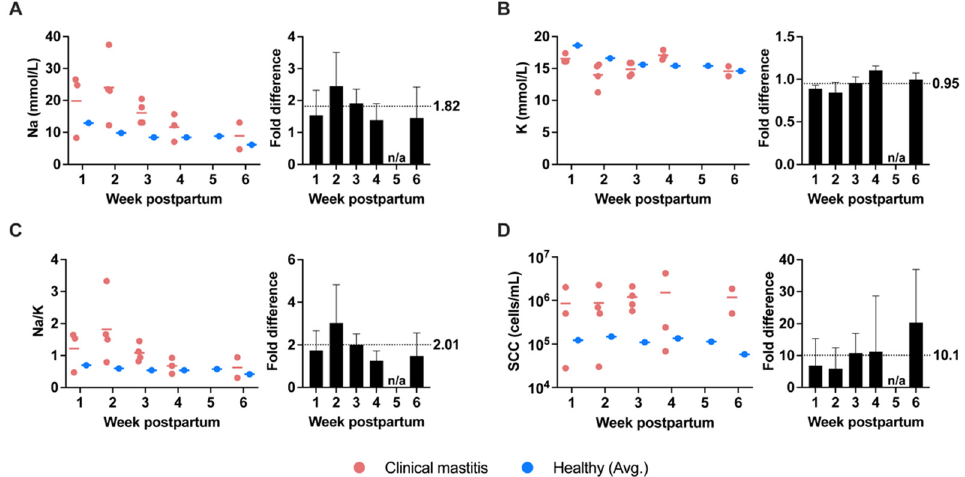
Figure 3. Measurements of ( A ) Na concentration, ( B ) K concentration, ( C ) Na/K, and ( D ) SCC during clinical mastitis and fold differences compared to healthy milk biomarker averages. Weekly average concentrations of each biomarker are denoted by solid horizontal bars. Fold differences were calculated by dividing the concentrations measured in mastitis samples by the average concentration of milk produced by healthy participants on a per-week level and are given as means (bars) ± standard deviations (error bars). Overall average fold difference for each biomarker is indicated by black dotted line within each respective panel; n/a, no available comparison.